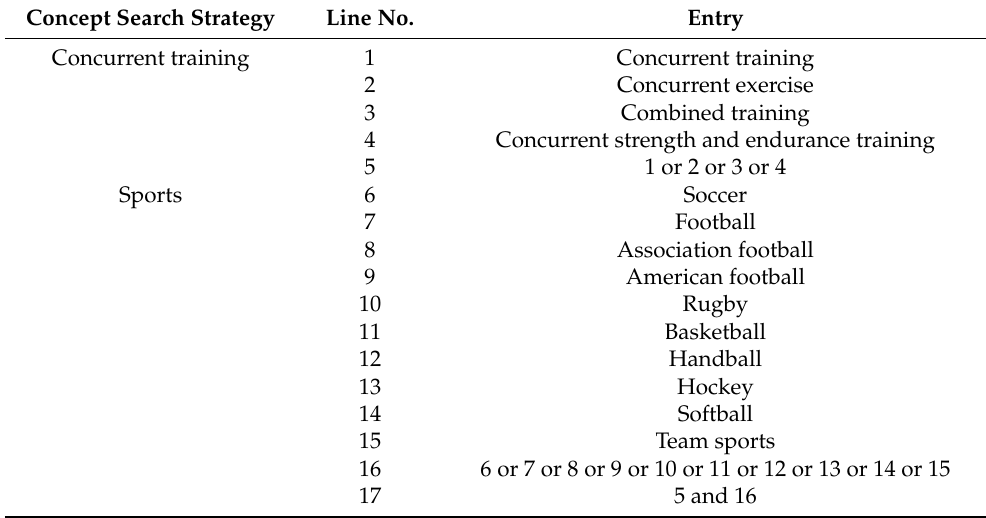
Table 1. Web of Science search strategy performed on 30 June